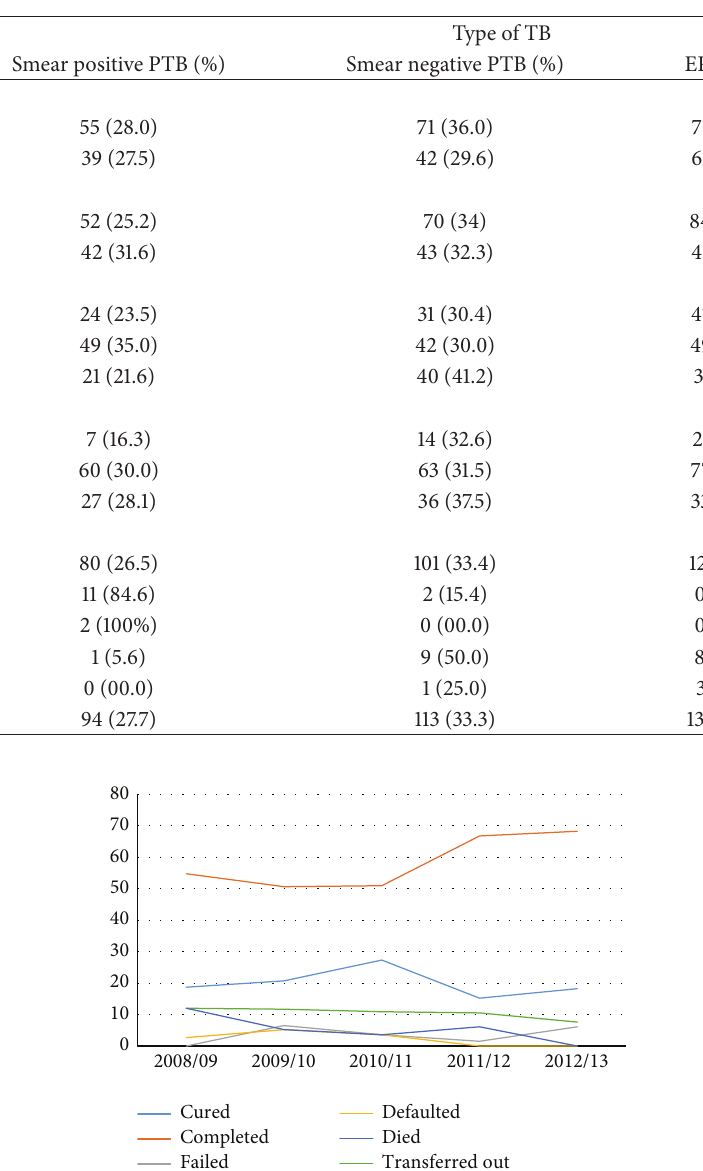
Table 2: Patients characteristics and type of TB at Debre Tabor Health Center, 2008–2013.